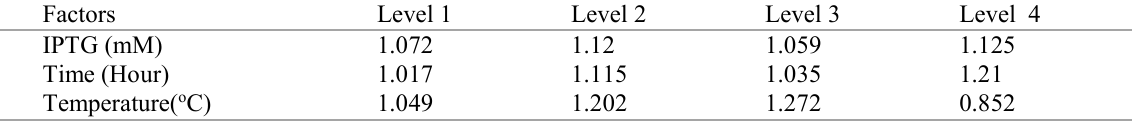
Table 1. Main factors (average effects of factors and interactions).